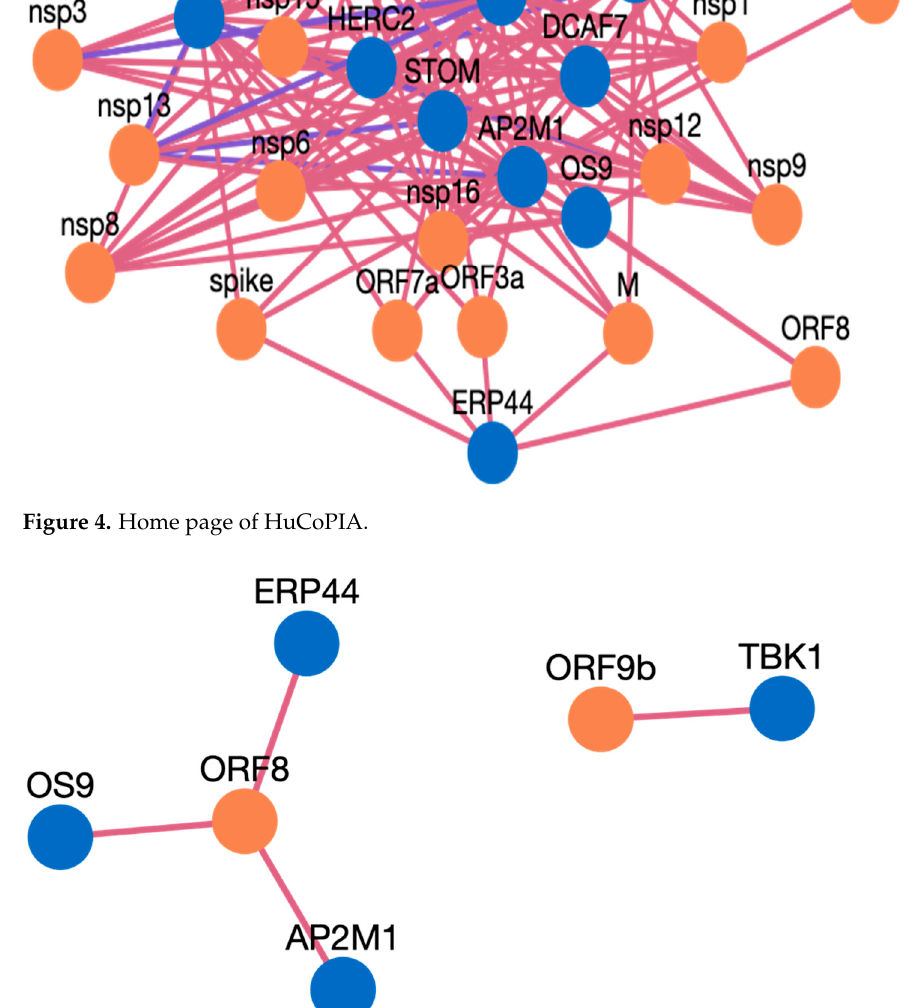
Figure 5. Network visualization of HPIs between ten genes and SARS-CoV.